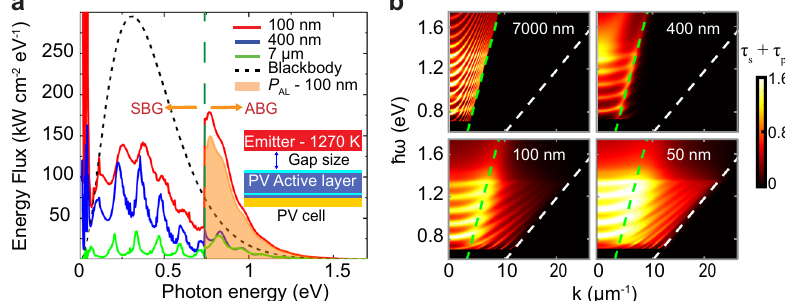
Fig. 4 Physical mechanism of NF enhancement. a The spectral energy transfer from a hot thermal emitter at 1270 K to a photovoltaic (PV) cell at 300 K is plotted as a function of photon energy for three gap sizes. The black dashed line represents the blackbody radiative limit between two semi-in fi nite plates at 1270 K and 300 K. Enhancement in above-band-gap (ABG) transfer is seen as the gap size is reduced down to 100 nm. The orange shaded region represents the radiative energy transfer ( P AL ) from the emitter to the InGaAs active layer, which drives the generation of charge carriers. Green dashed line represents the band gap of the PV cell while SBG represents the sub-band-gap region. Note that the energy fl ux for the 100-nm gap size at low energies (<0.1 eV) extends beyond the y-axis range. b The total transmission function of different modes from the emitter to the active layer, as a function of photon energy and parallel wavevector at four gap sizes. The green dashed line represents the light line in vacuum, while the white line represents the dispersion relation in the top InP the rest is lost due to thermalization, nonradiative recombination and ohmic losses (see Supplementary Note 7). Next, the ef fi ciency trend as a function of gap size can be understood by comparing the spectral energy transfer at three gap sizes of 7 µm (far fi eld), 400 nm, and 100 nm. In the far fi eld (green line), a large suppression of SBG energy transfer is